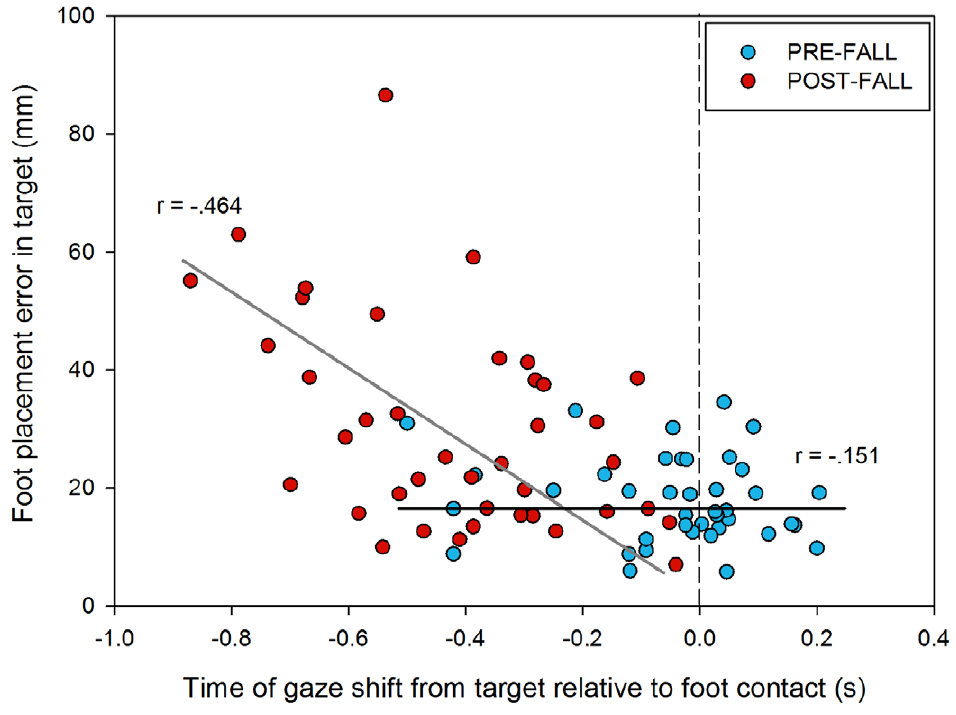
Figure 3. Correlation between the time of gaze transfer from the stepping guide and corresponding absolute foot placement error. Vertical dashed lines represent the time of foot contact in the stepping guide. The black and gray solid lines represent the lines of best fit for pre-fall and post-fall data, respectfully.